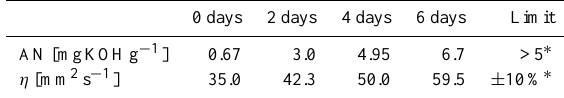
Table 6. Acid number (AN) and kinematic viscosity η for ester- based hydraulic fluid (Meguin HETG 37); artificially aged